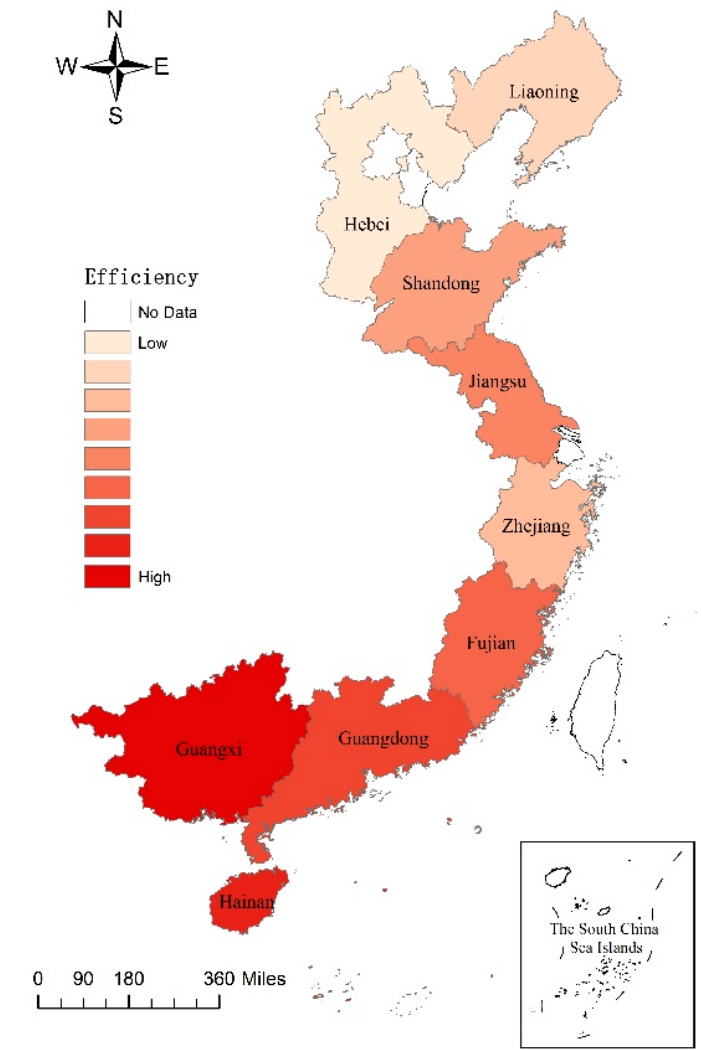
Figure 3. Difference in spatial distribution of the marine aquaculture efficiency in China, 2016. Figure 3. Di ff erence in spatial distribution of the marine aquaculture e ffi ciency in China,